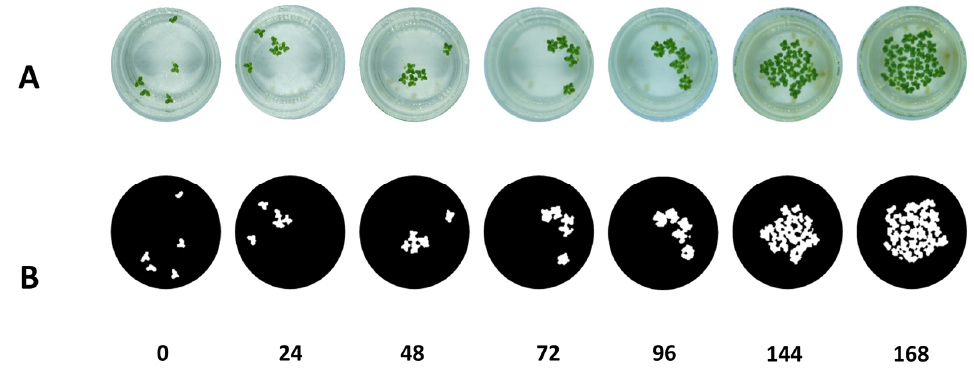
Figure 5. ( A ) pictures of Lemna minor at different time intervals ( B ) pictures processed by the ilastik ® software (version .